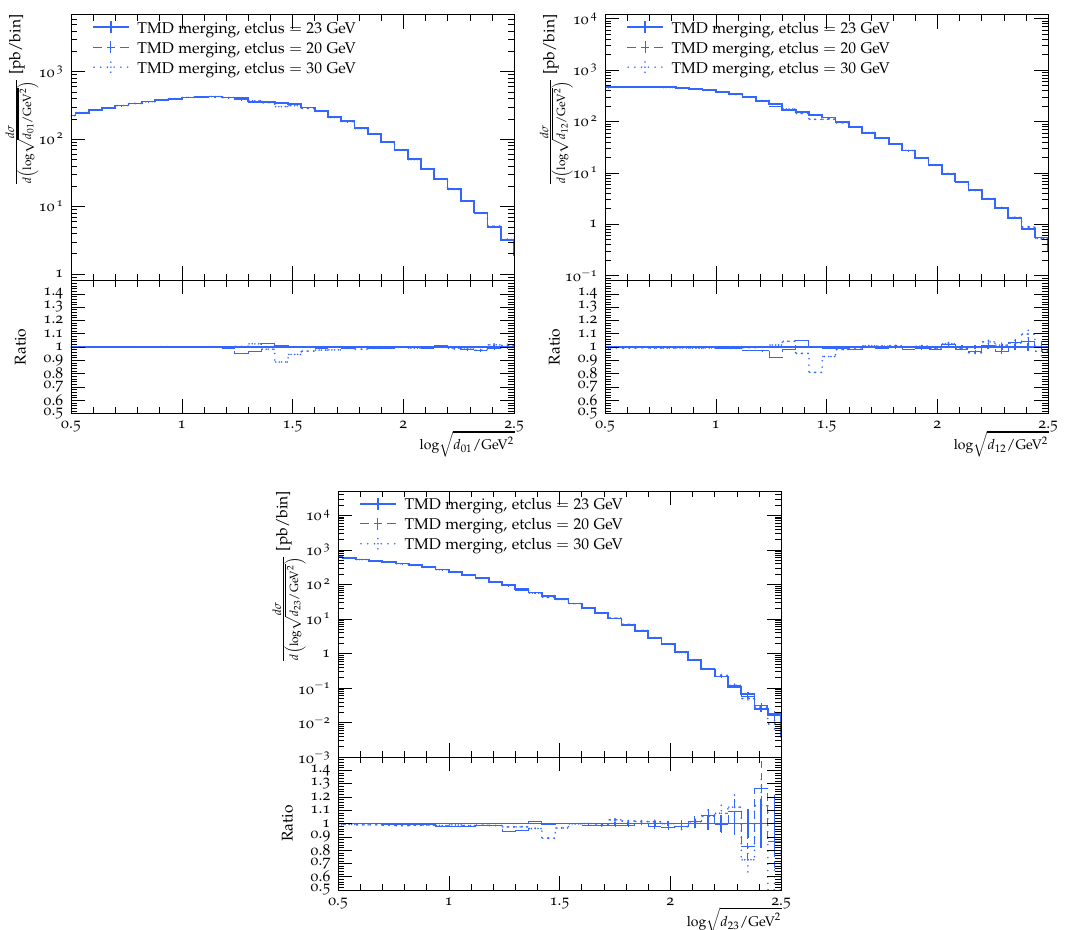
√ Figure 21 . TMD merging systematic uncertainty at the LHC at s = 8 TeV. The d n,n +1 spectra for n = 0 , 1 , 2 , where d represents the energy-square scale at which an ( n + 1) -jet event is n,n +1 resolved as an n -jet event in the k jet-clustering algorithm, are calculated for three different ⊥ values of the merging scale. The solid line represents the default